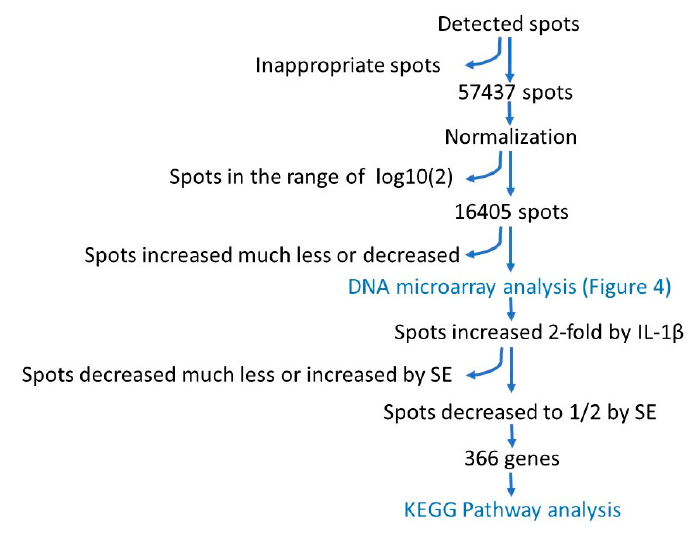
Figure 3. Flow chart of DNA array analysis.